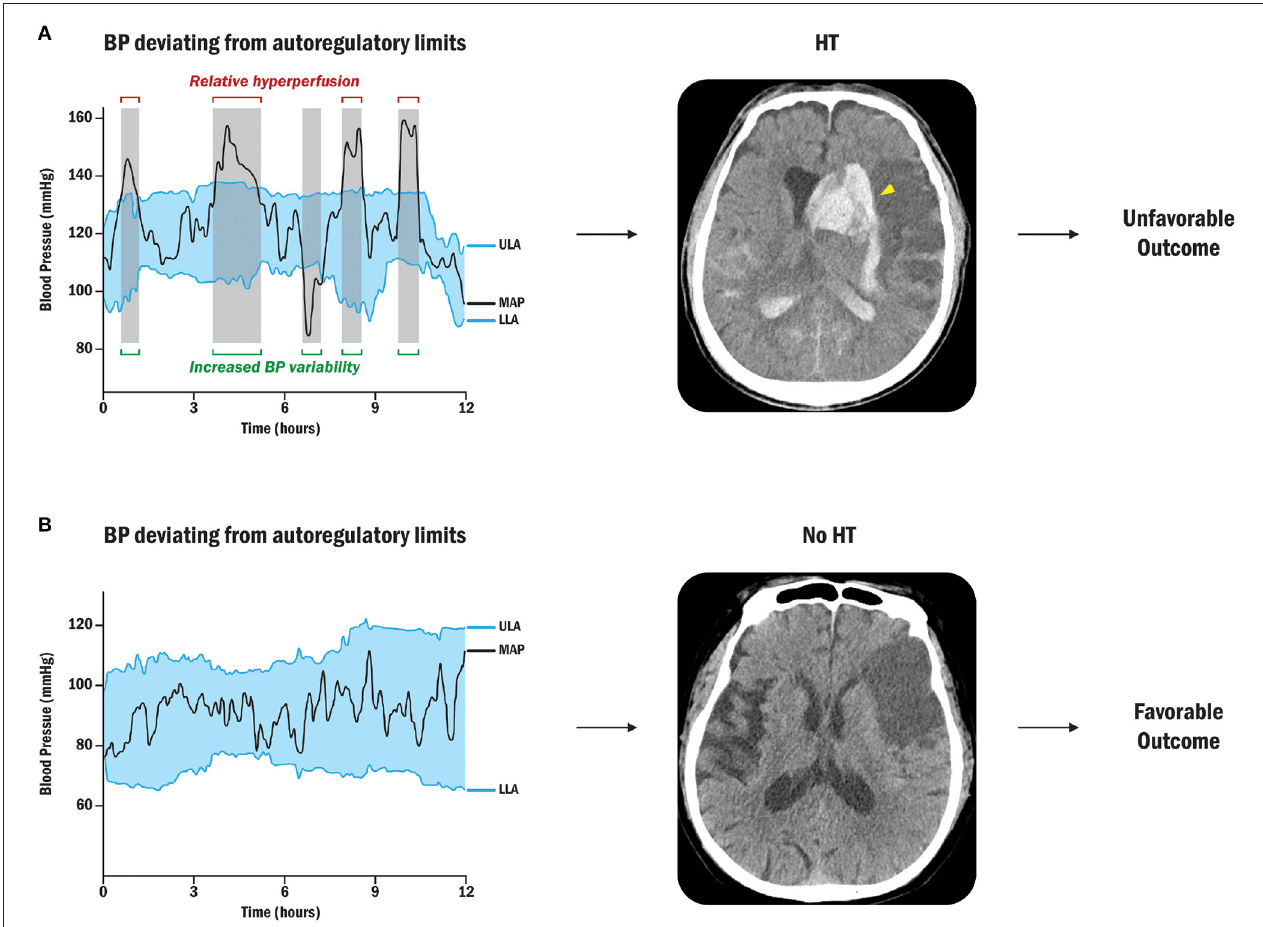
FIGURE 3 | Sequential BP changes, cerebral autoregulation, and HT (91). (A) Patient with BP deviation from autoregulatory limits: Relative hyperperfusion above the upper limit of autoregulation may lead to HT and unfavorable outcomes. The yellow arrowhead points out the radiological HT after cerebral ischemic stroke. (B) Patient with acceptable BP fluctuations: Strictly controlled blood pressure within personalized limits of autoregulation can prevent secondary brain injury by protecting against HT after stroke. BP, blood pressure; ULA, upper limit of autoregulation; MAP, mean arterial pressure; LLA, lower limit of